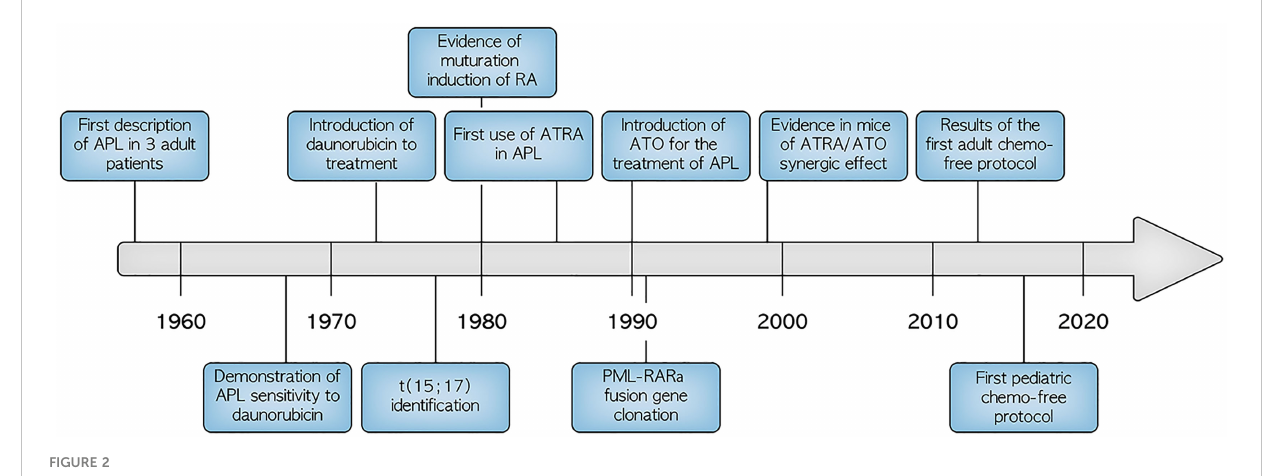
FIGURE 2 Timeline of the main steps in the development of chemo-free protocols for pediatric